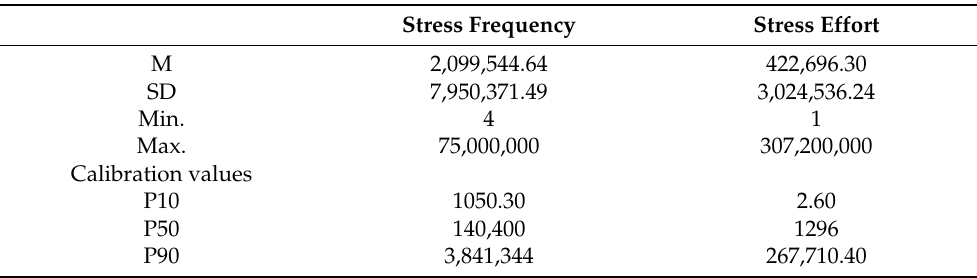
Table 4. Calibration values for the qualitative comparative analysis model predicting perceived caregiver stress (n = 140).